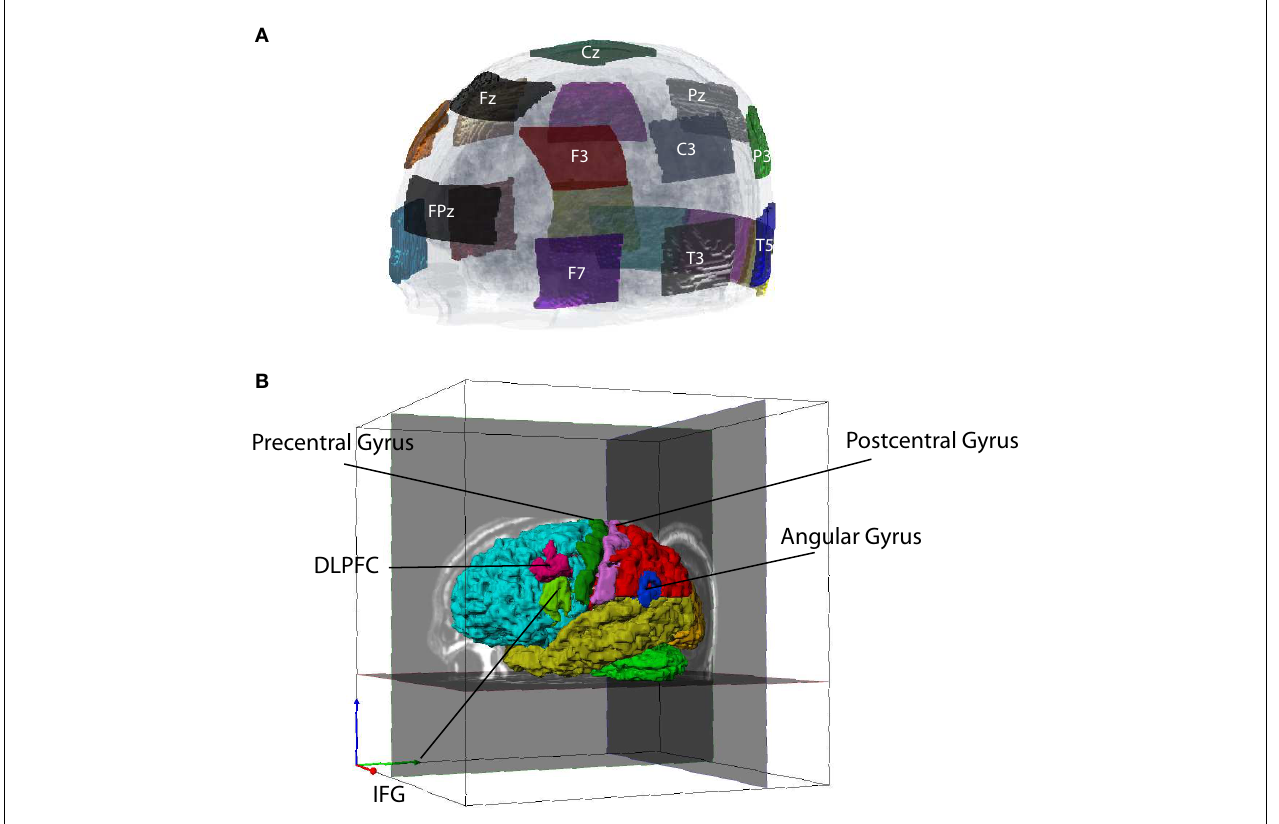
temporal (yellow), occipital (orange) lobes, cereballar gray matter (green), angular gyrus (AG, blue), dorsolateral prefrontal cortex (DLPFC, cyan), inferior frontal gyrus (IFG, light green), precentral cortex (dark green), and postcentral cortex